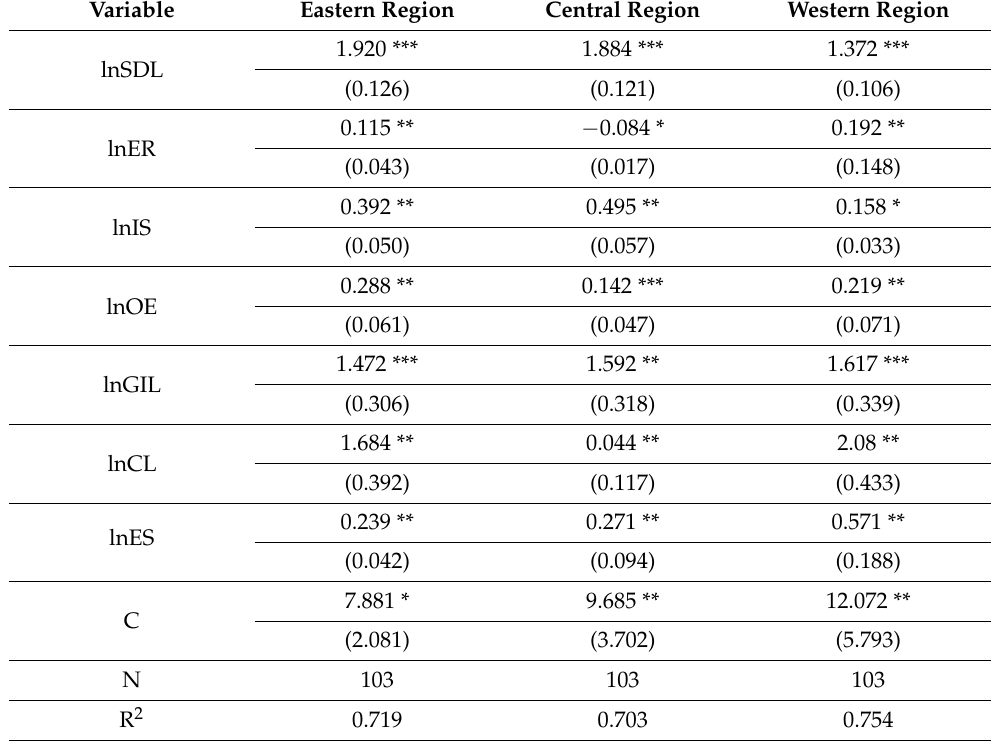
Table 8. Estimation of regional heterogeneity.